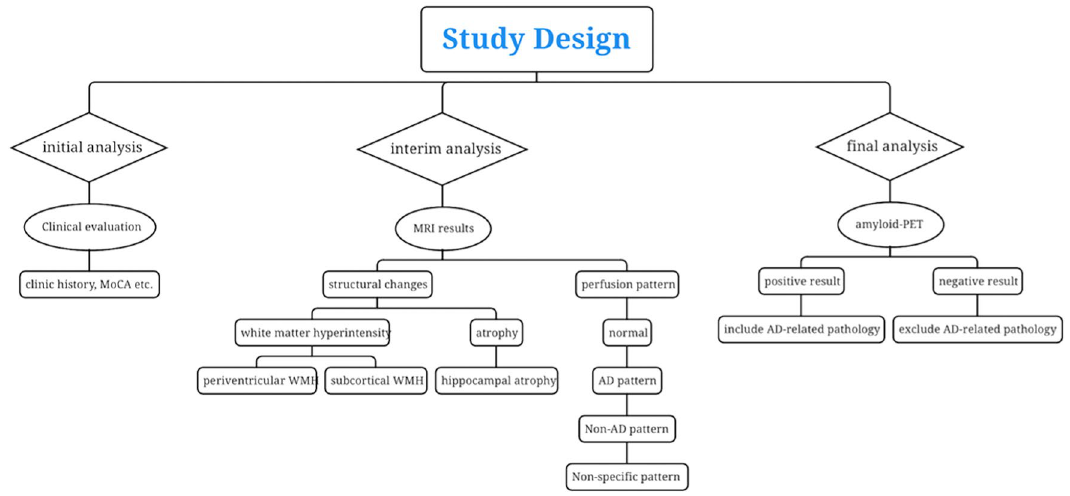
Figure 1. Flowchart of the study and assessments of neuroimaging in cognitive